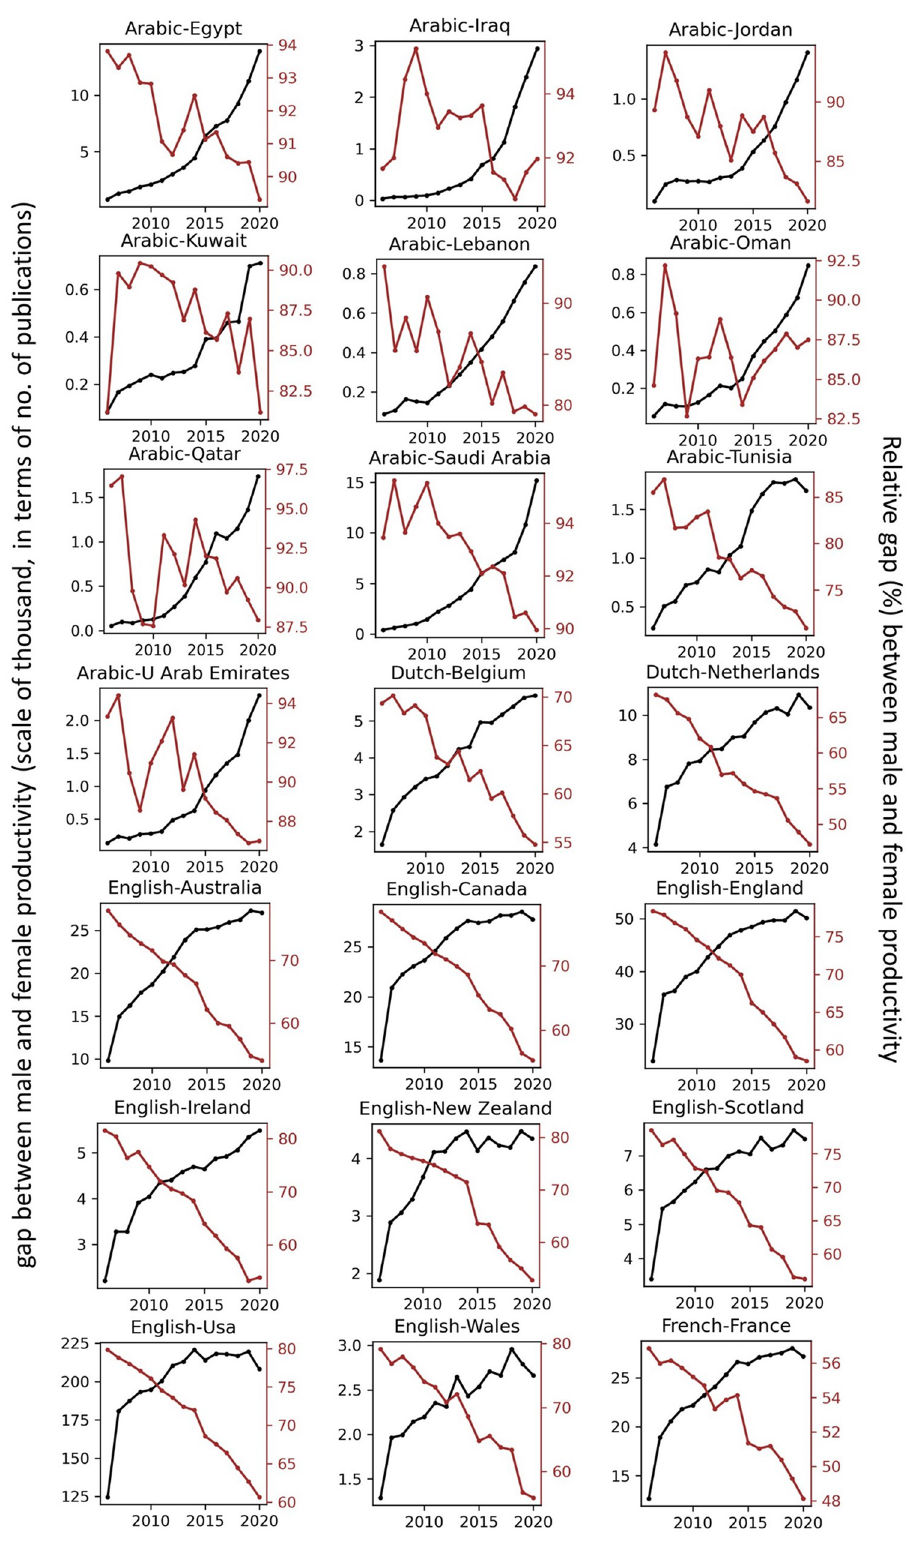
Fig 17. Gaps between male and female total research productivity, A-Z method (part 1).